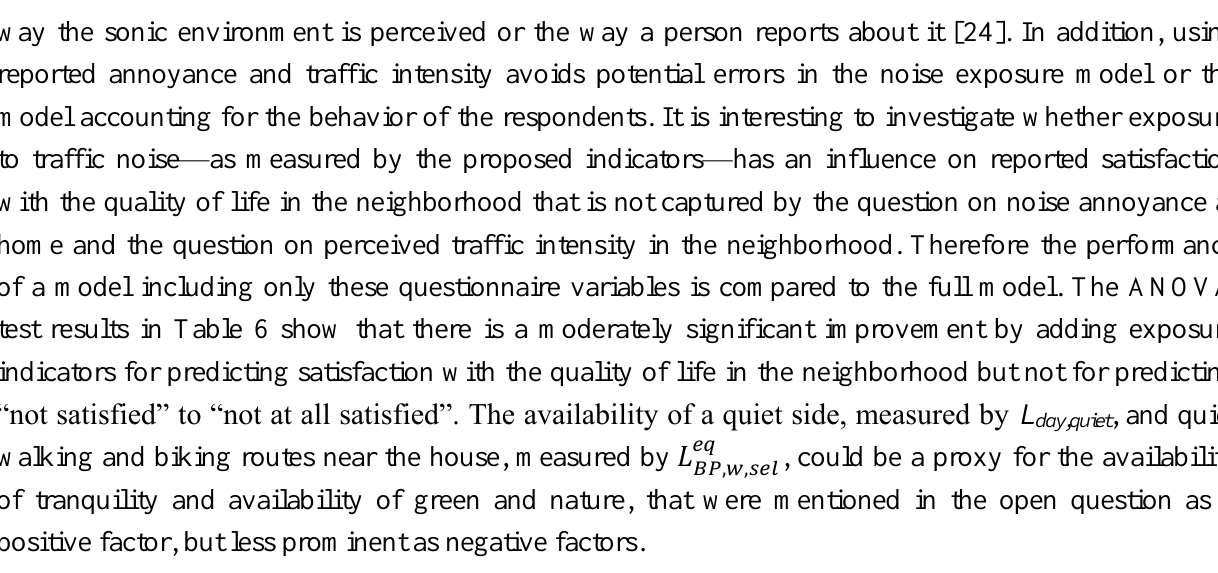
Table 5. p in chi squared test for logistic model predicting satisfaction with the quality of life in the neighborhood (Q1.1); label “not satisfied” covers the last two response categories on the five point scale, the label “satisfied” the first two response categories. L